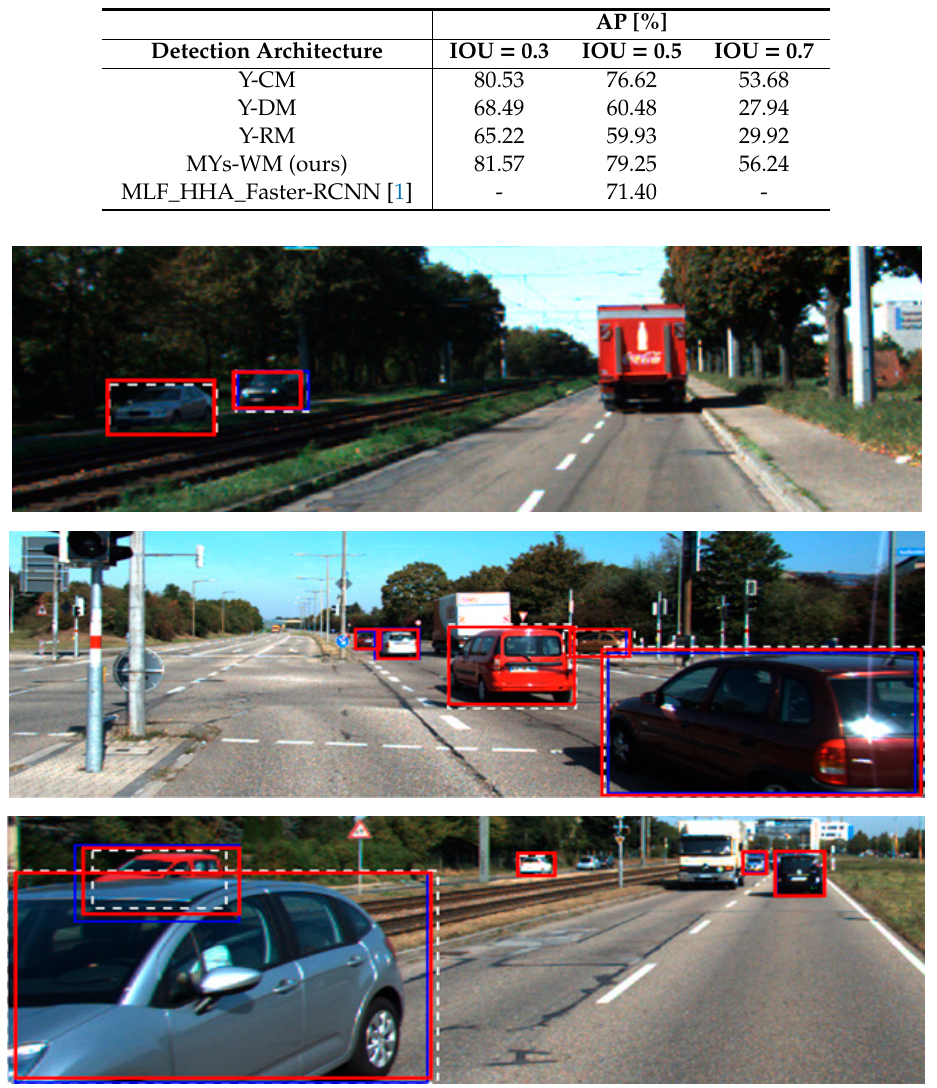
Table 2. Comparison of detection of pedestrians according to IOU.